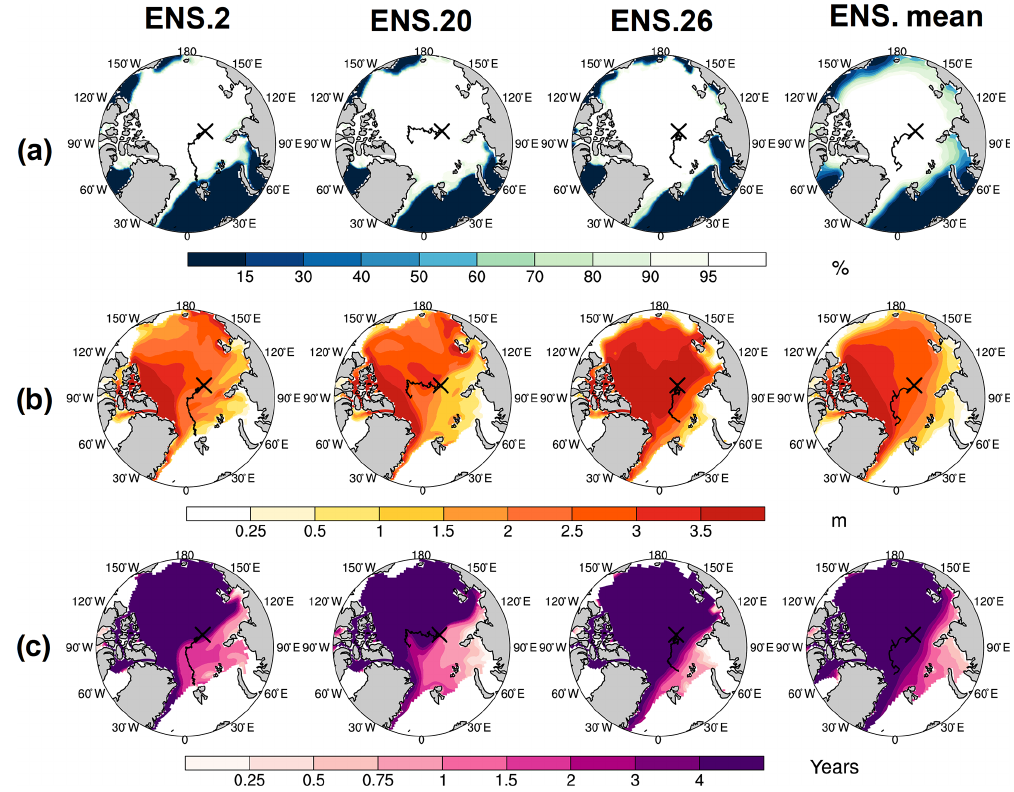
Figure 4. Perennial grid cell daily mean sea ice concentration (a) , thickness (b) , and ice age (c) on 15 October. Three random ensembles from the CESM-LE and the ensemble mean are shown. The black “X” in each map denotes the campaign starting location. The Lagrangian tracks for each ensemble member and the representative track from Fig. 1 for the ensemble mean are overlaid as black